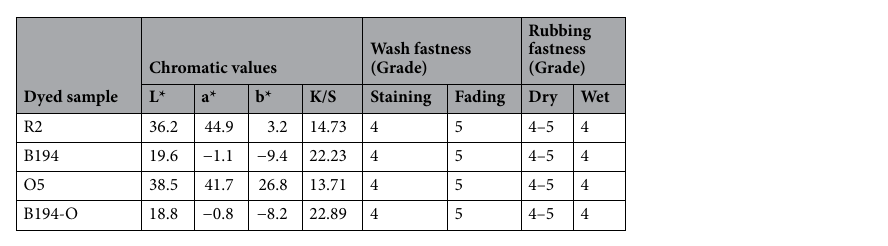
Table 11. Chromatic values and colorfastness of dyed grass